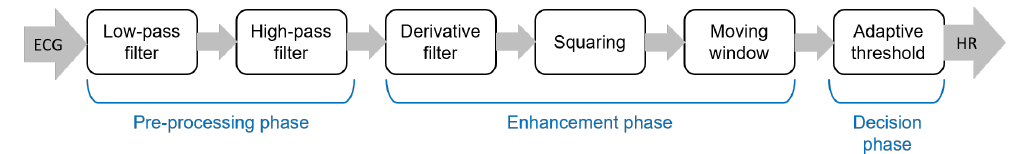
Figure 3. Main steps of the well-known Pan–Tompkins [46] algorithm to detect